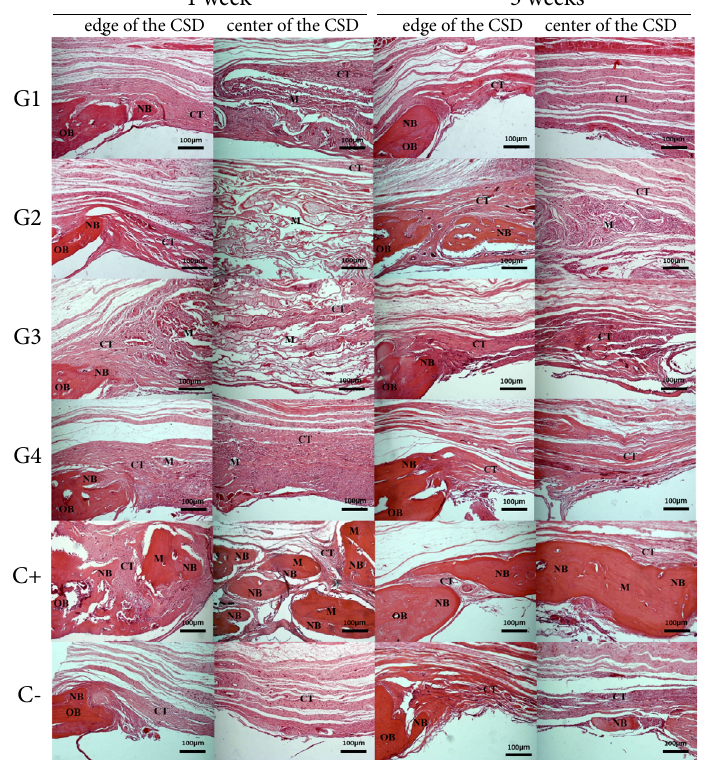
Figure 7 - Osteoconductivity analysis of poultry collagen-based hydrogels in critical size bone defect in rat calvaria at one and three